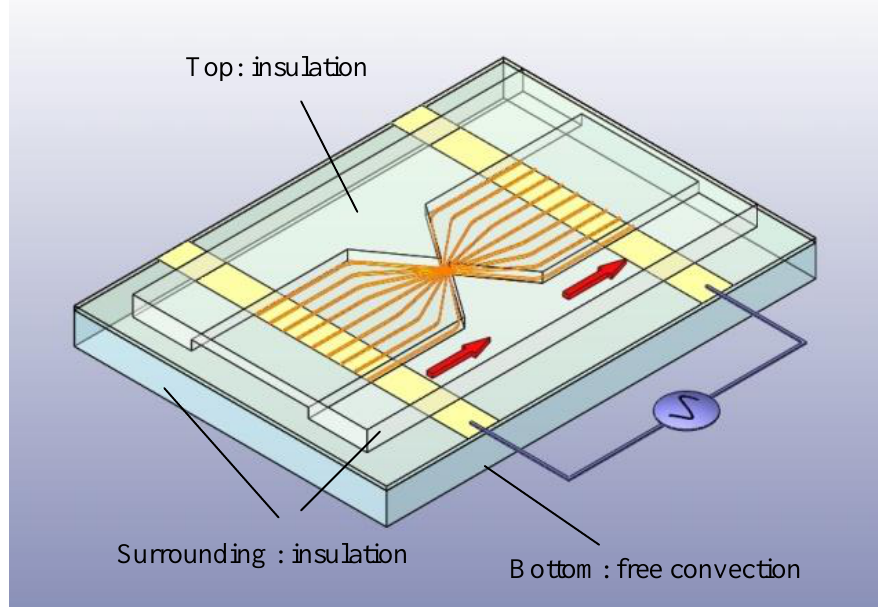
Figure 1. Schematic EDEP-based microfluidic device, comprising a pair of triangular insulating structures, a microchannel, and a pair of driving electrodes. Additionally, boundary conditions of the 3-D numerical simulation described in a triangular insulating structure are